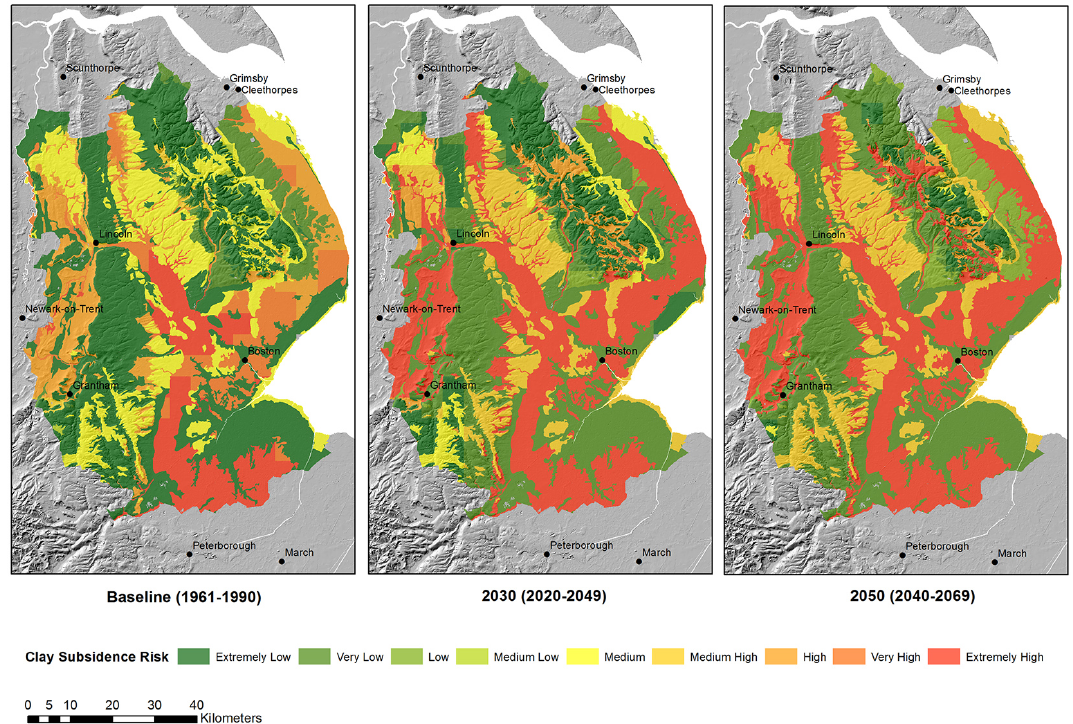
Figure 3. Modelled clay-subsidence risk at the central estimate (50th percentile) for baseline (1961–1990), 2030 (2020–2049) and 2050 (2040–2069) UKCP09 scenarios for the administrative county of Lincolnshire (contains Ordnance Survey data, Crown copyright and database right, 2015; soil data (England and Wales) © Cranfield University and for the controller of HMSO